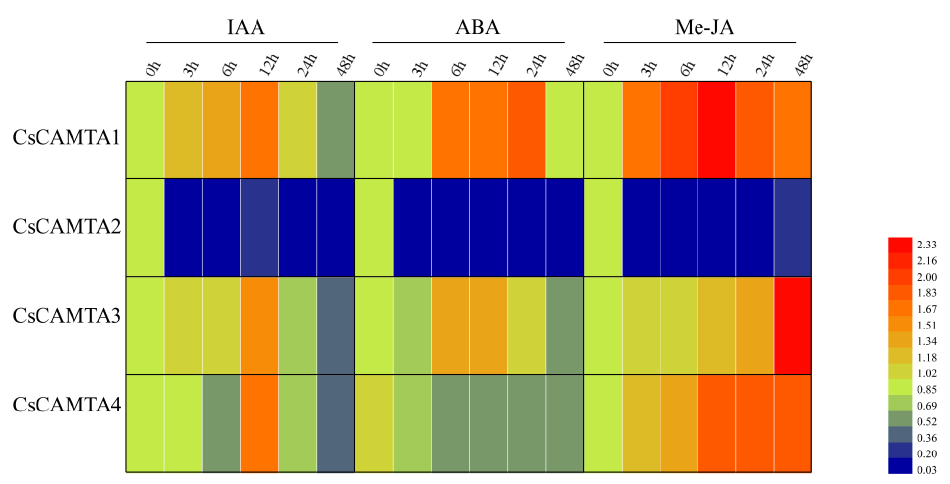
Figure 6. The expression pattern of CsCAMTA genes in leaves treated with indole-3-acetic acid (IAA), abscisic acid (ABA), and methyl jasmonate (MeJA). The sampling time points were 0, 3, 6, 12, 24, and 48 h. Red and blue indicate high and low levels of expression level, respectively. The color bar represents the expression values.